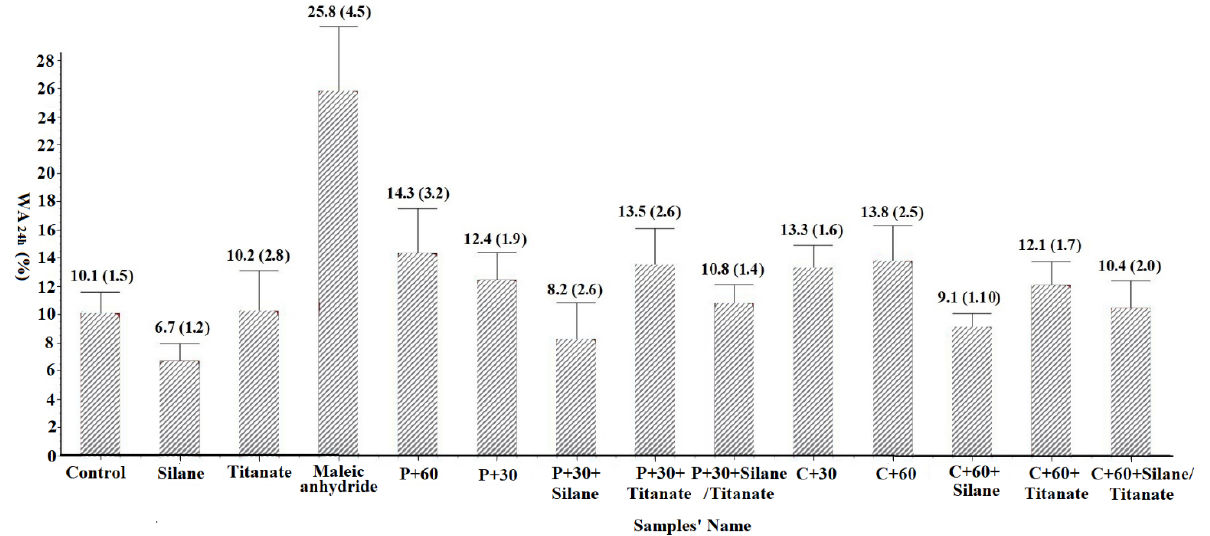
Figure 3. The water absorption for 24 h (WA 24h ) of composites (Values represent means of 10 replicates/test. Values in parentheses represent one standard deviation; the detail for samples’ name shown in Table 1).